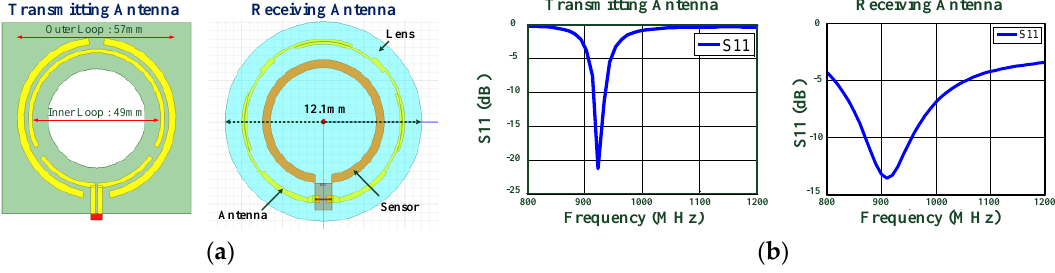
Figure 2. ( a ) Prototypes of transmitting (left) and receiving antennas (right); ( b ) Simulated | S 11 | of transmitting antenna (left) and receiving antenna (right).